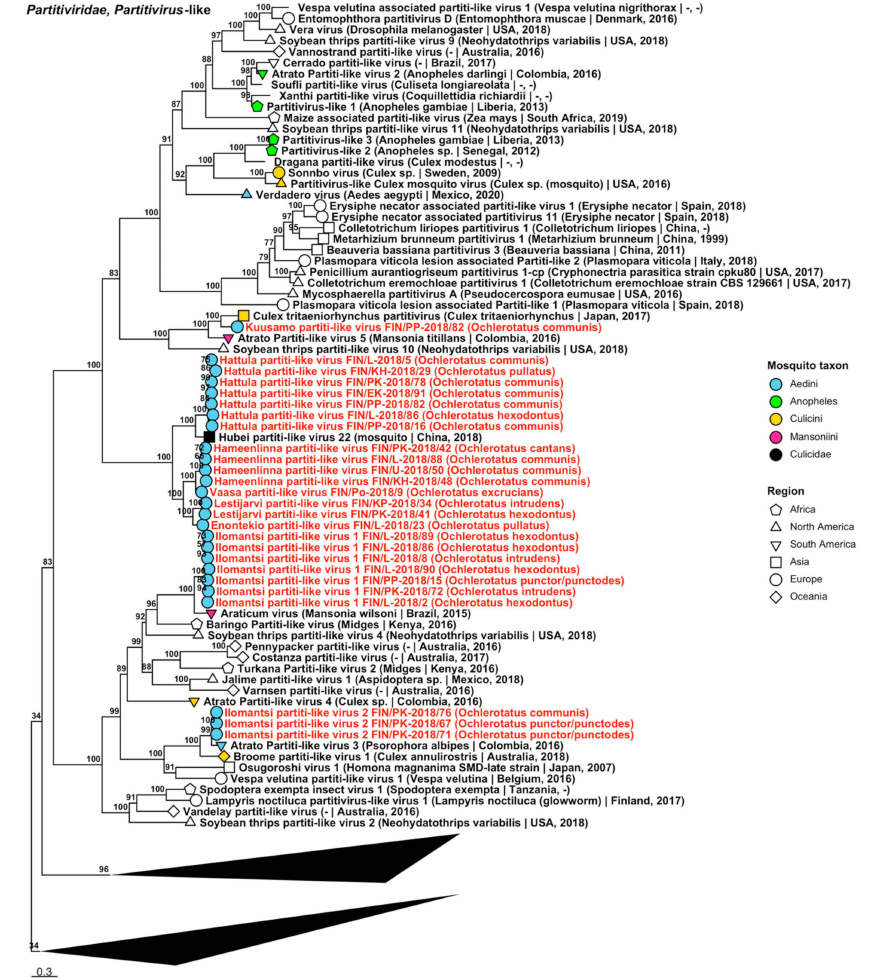
Figure 19. Maximum likelihood tree of partiti-like viruses ( Partitiviridae ). Tentative novel viruses are displayed in red and the mosquito species from which they were derived are in parentheses. Sequences from GenBank are black and display the following information after the virus or species name: “(sampled organism(s)|collection country, collection year)”. Tip colours represent the tribe (Culicinae) or genus (Anophelinae) of mosquito from which viruses were obtained. Tip shape represents the continent or region from which the specimens were collected. Trees were constructed from amino acid sequences of virus polymerases >1000 nt, aligned with MAFFT and computed with IQ-TREE2 using ModelFinder and 1000